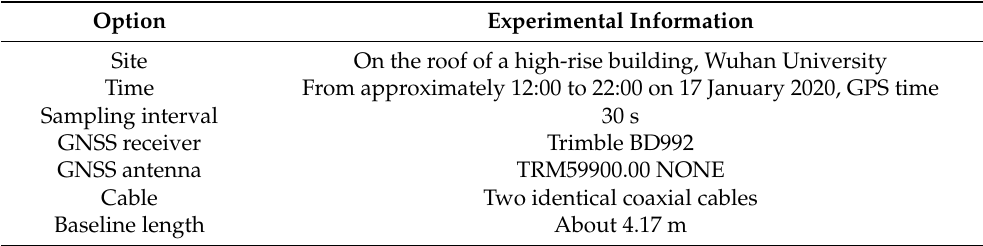
Figure 2. Numbers of GPS/Galileo satellites and the PDOP series of combined GPS/Galileo under a 10° elevation cutoff angle. Table 2. Detailed information about the experimental